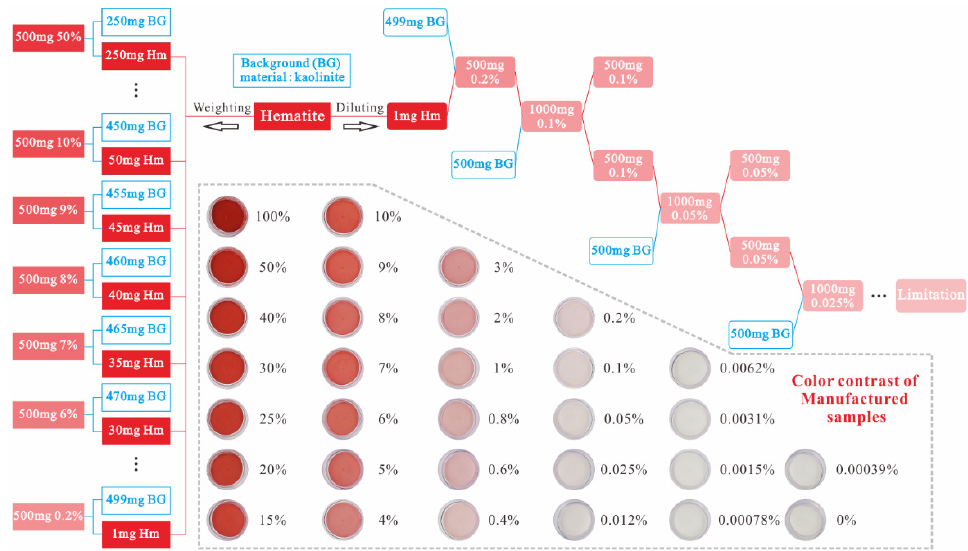
Figure 1. Synthesizing process and color contrast of manufactured samples.